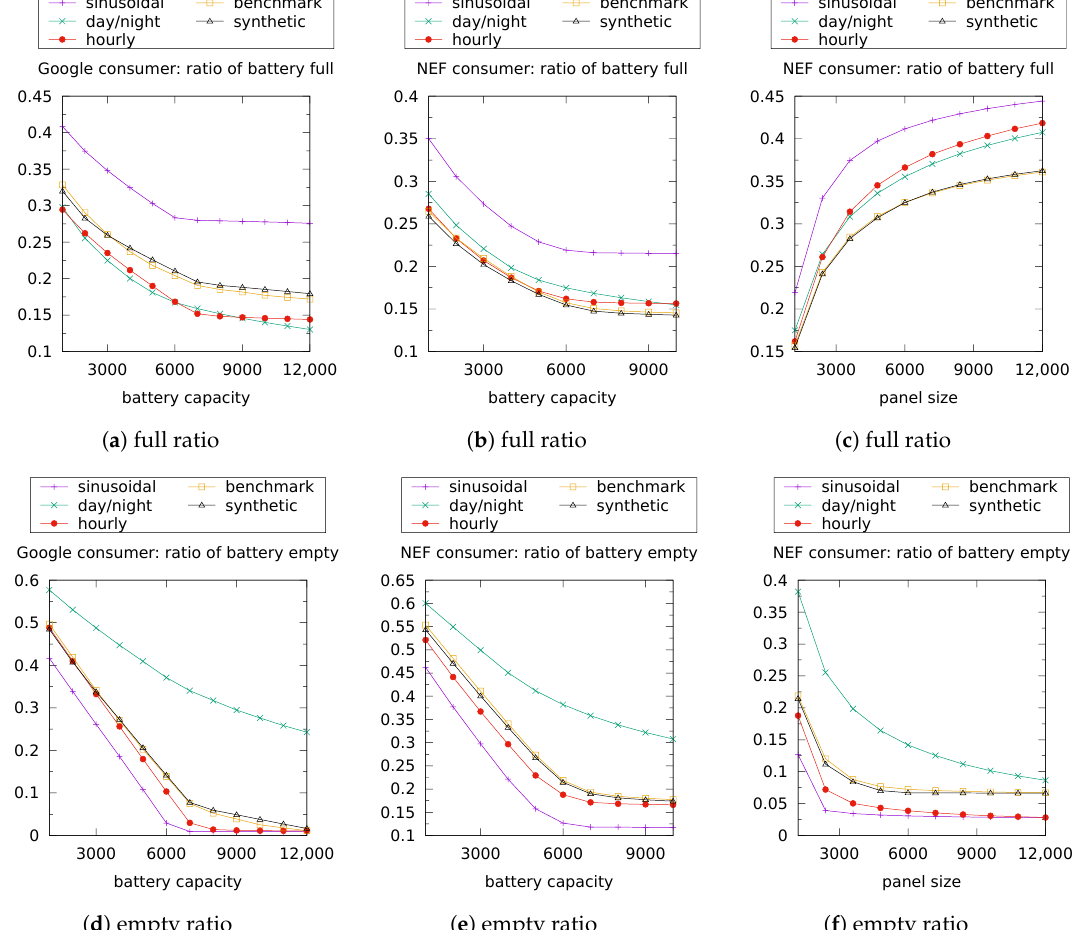
Figure 16. Experiments for Portland: full ratio ( a – c ) and empty ratio ( d – f ) as the battery capacity varies (( a , b , d , e ) panel surface 1200 m 2 ) and as the panel surface varies (( c , f ) battery capacity 6000 MJ).